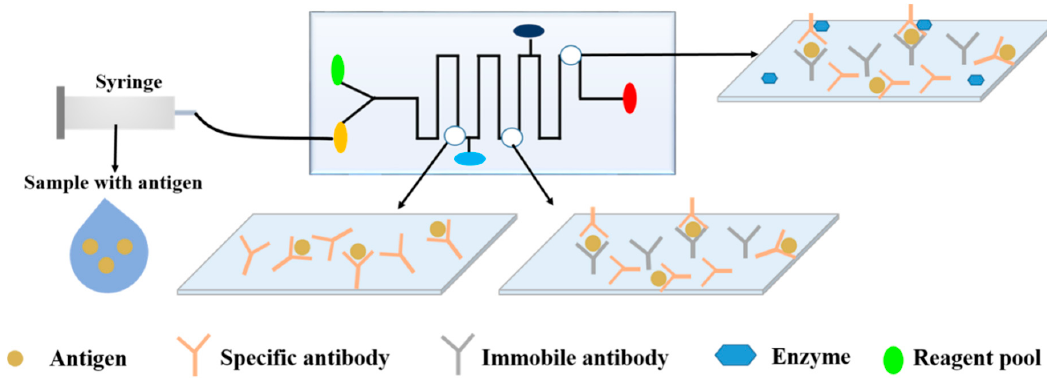
Figure 5. The basic principles of immunoassay-based microfluidics for the detection of foodborne